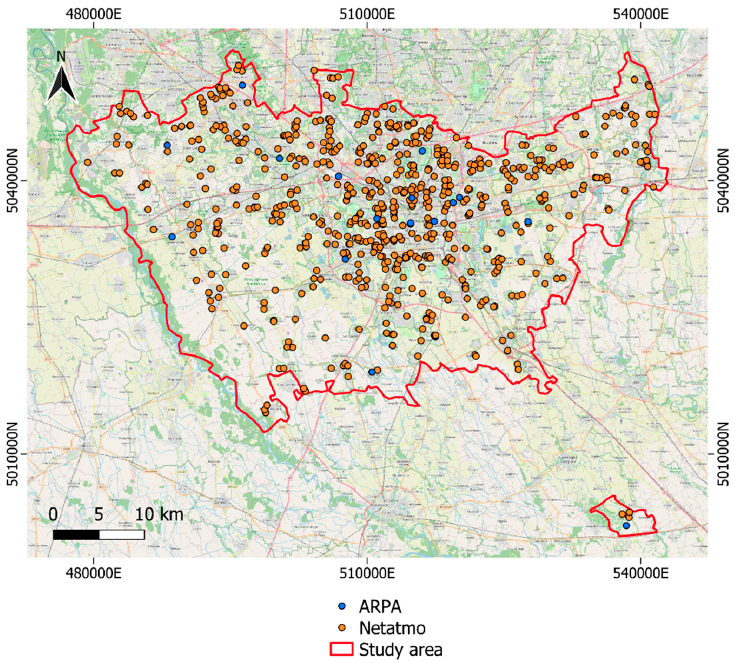
Figure 2. Locations of Regional Agency for Environmental Protection (ARPA) and Netatmo stations in the study area for the year 2021. CRS: WGS84/UTM zone 32N. Basemap data: © OpenStreetMap Contributors.